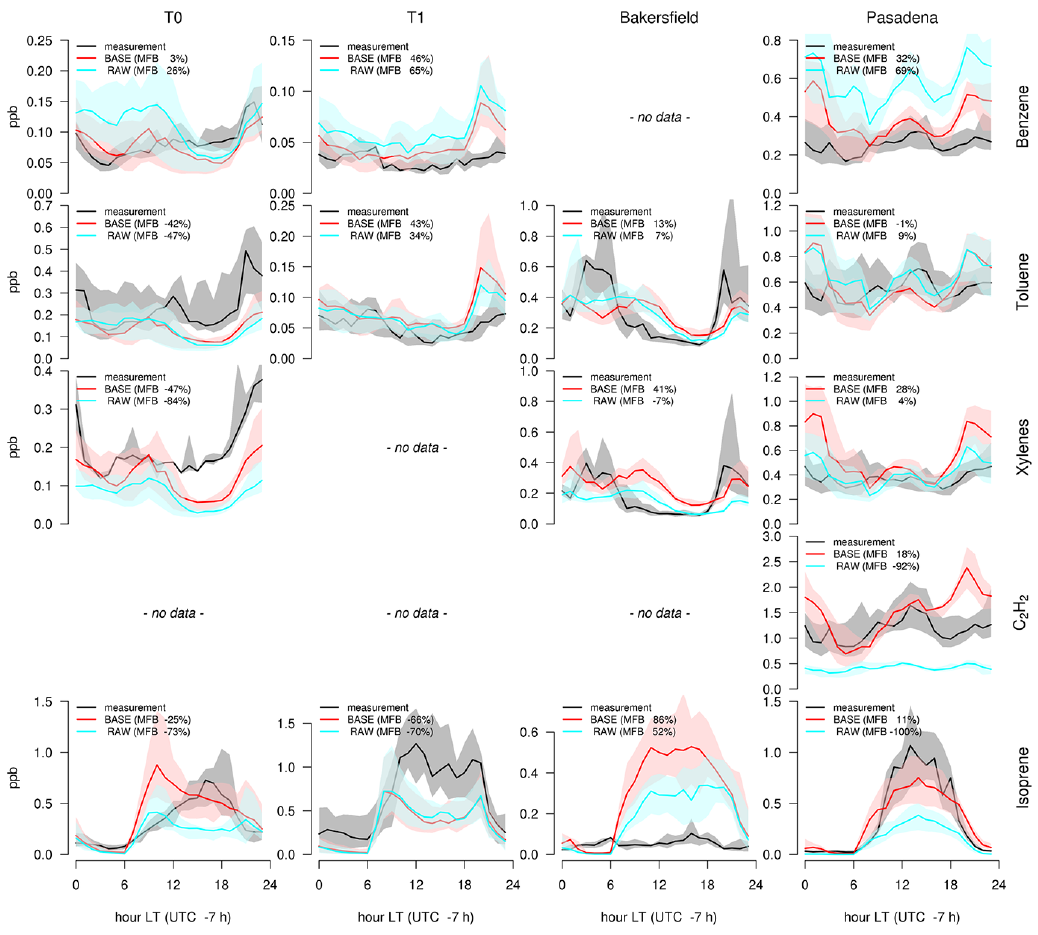
Figure 4. Averaged (29 May 00:00UTC–16 June 00:00UTC) diurnal cycles of measurements at the supersites (black) and model results using the original (RAW, blue) and updated emissions inventory (BASE, red) for the main precursors of glyoxal. Shown are the mean as solid line and the 25–75% range as shaded areas. MFB indicates mean fractional bias against measurements.